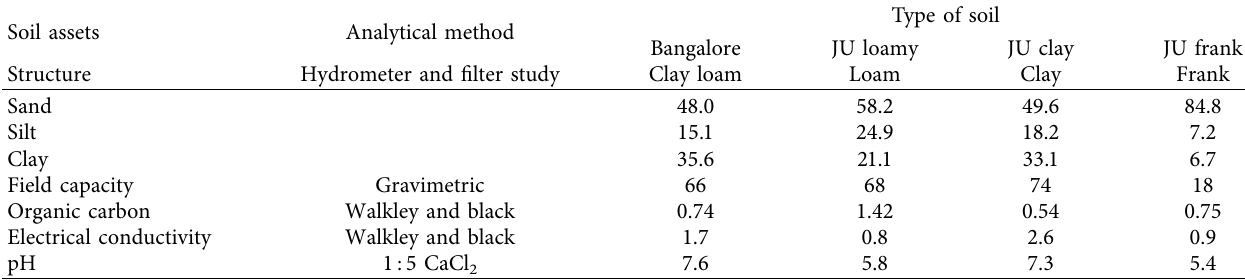
Table 2: Experimented data of soil